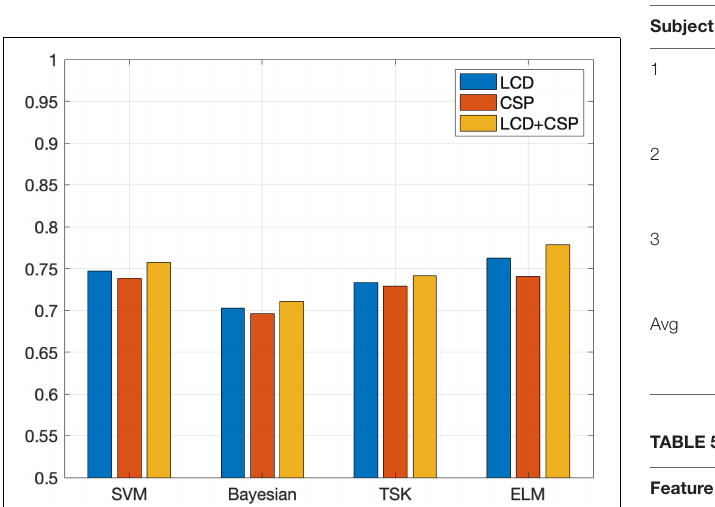
TABLE 4 | Classification accuracy of data sets IIIa.